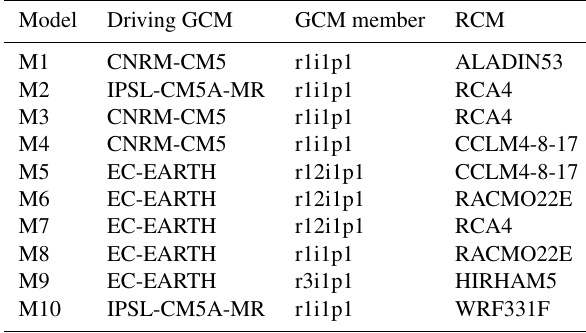
Table 1. Models used in this